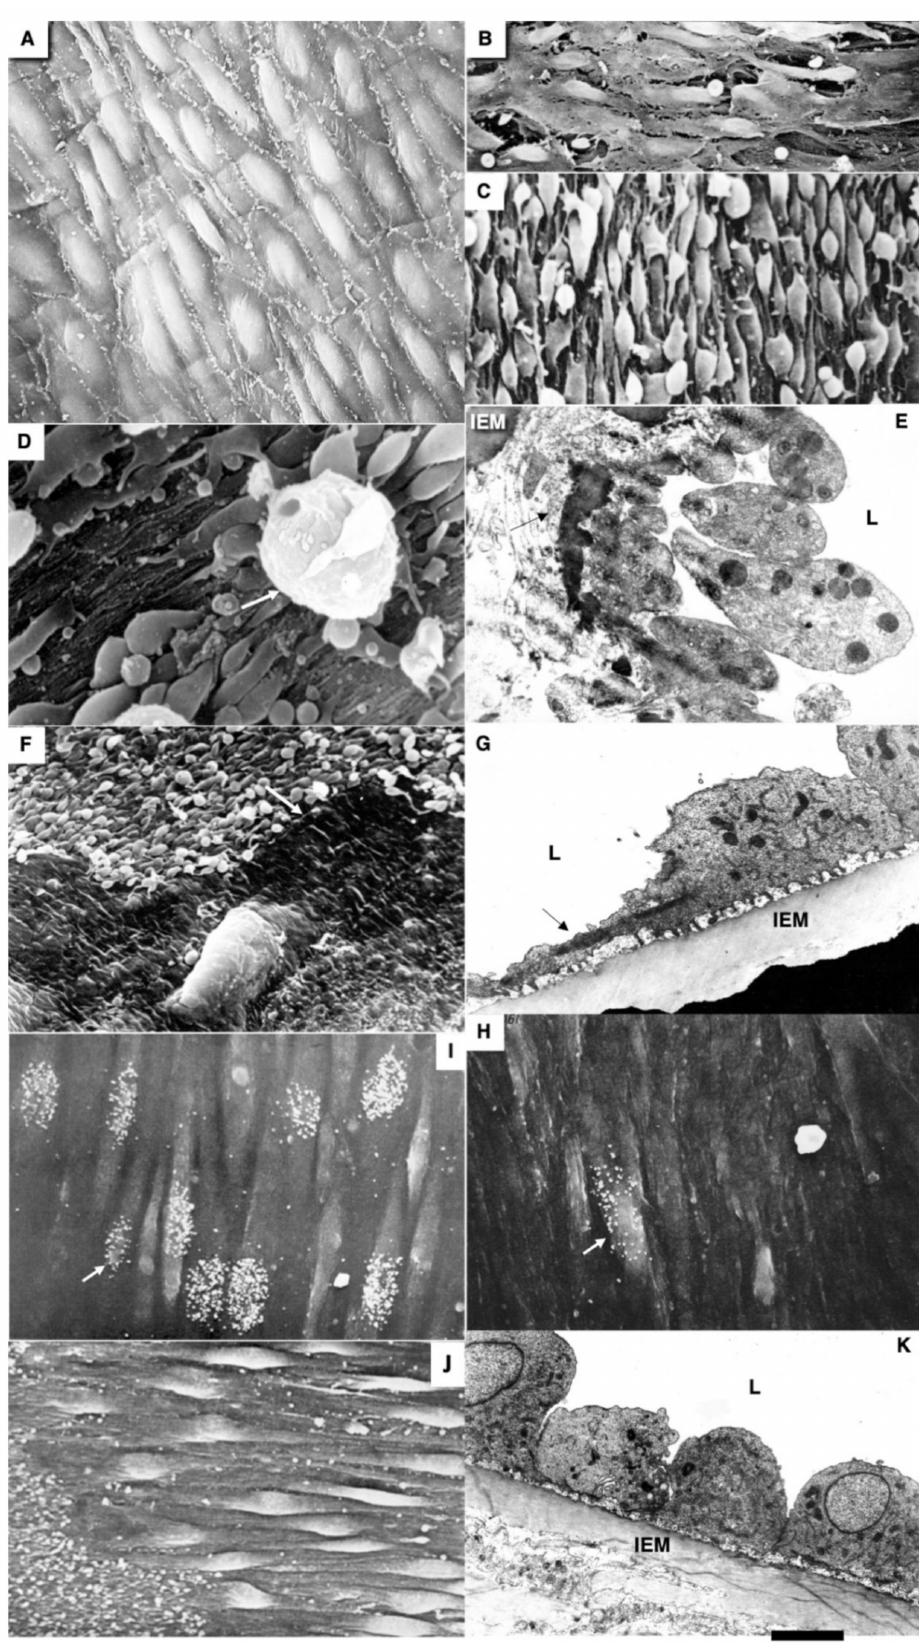
Figure 2. Alterations of aortic ECs after cryoinjury. ( A ) Control sample from the rat treated with the copper probe with the temperature equal to 37 ◦ C. Normal structures of ECs. Scanning